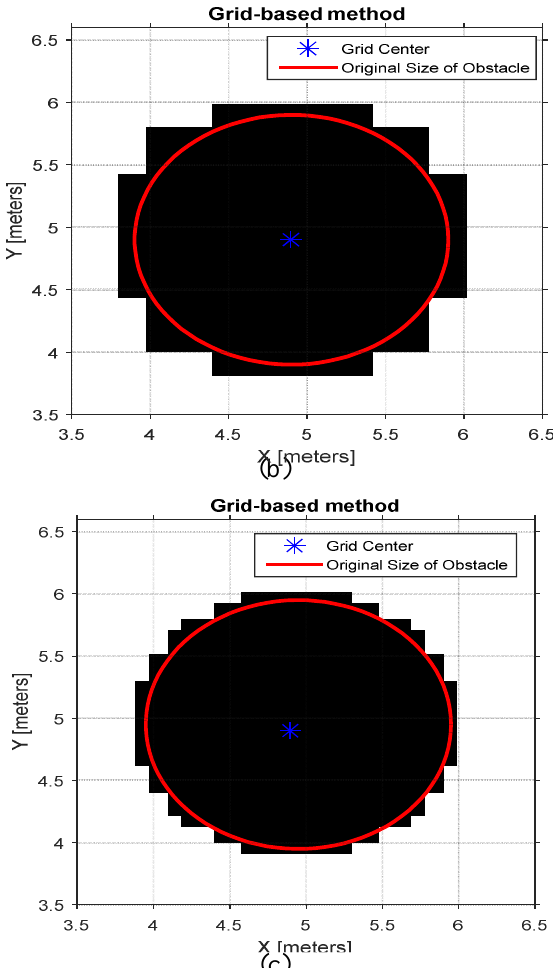
Fig. 3. (a) Grid-based method with resolution (1), (b) Grid-based method with resolution (5) (c) Grid-based method with resolution